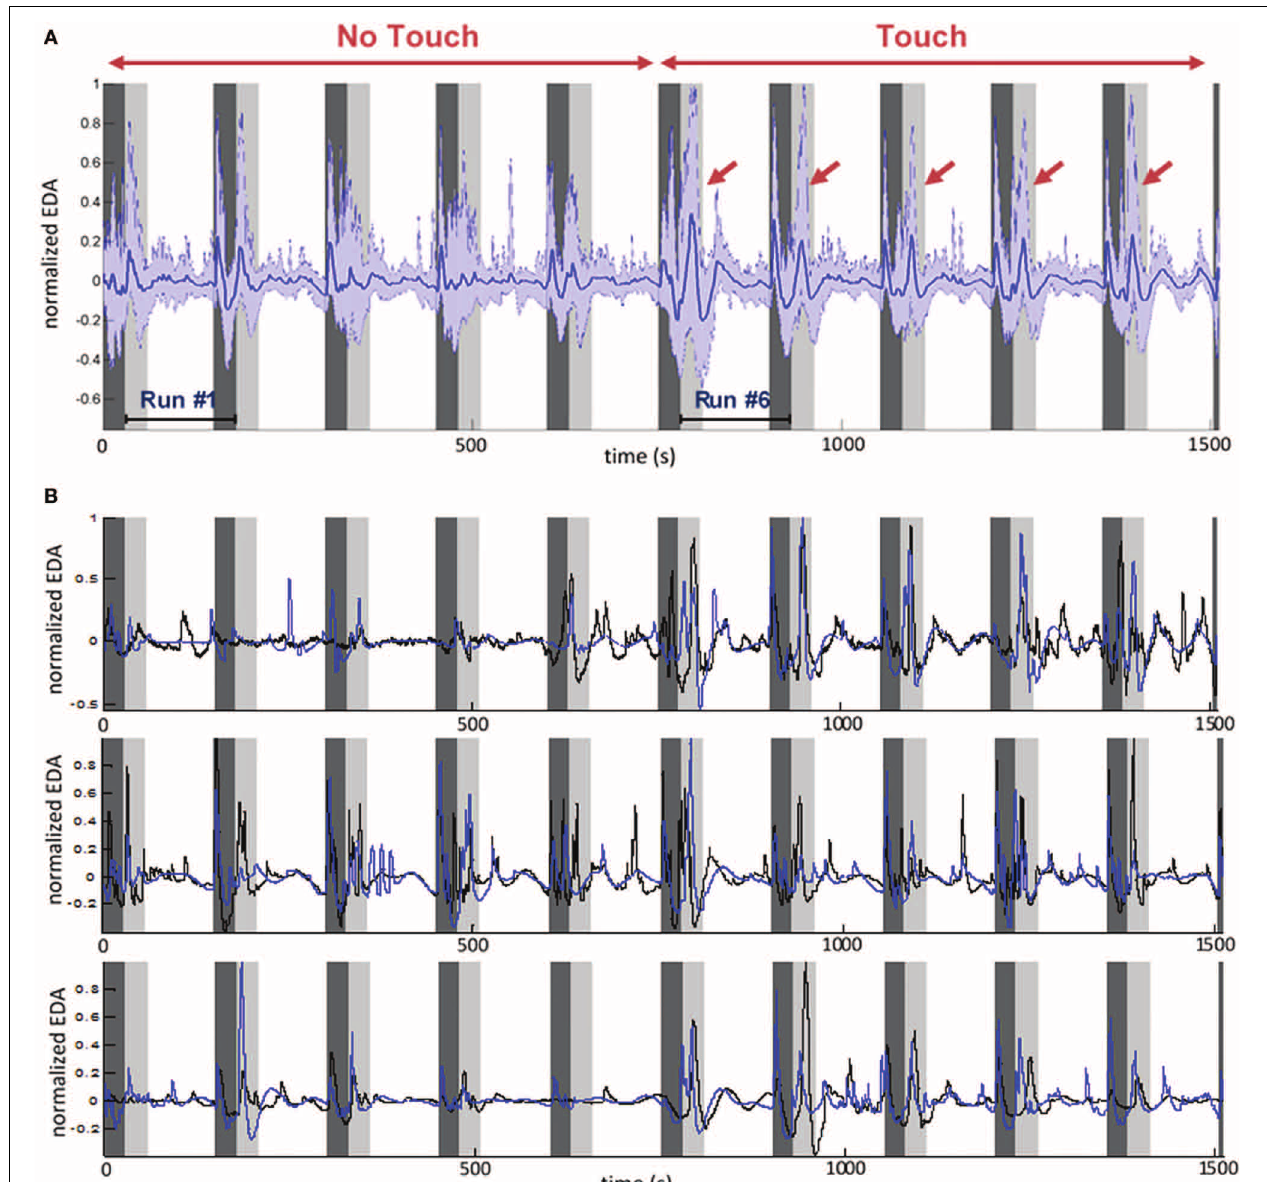
FIGURE 4 | Time course of electrodermal activity (EDA) during the entire experiment. The sequence of 10 runs is shown. Dark gray area: rest periods. Light gray area: first 30sof eachrun. Run 1–5: NoTouch block. Run6–10: Touch block. (A) EDA averaged for all participants ( N = 28). Dark blue: mean value. Light blue: 5 and 95th percentiles. Red arrows show touch-related ER-SCR.